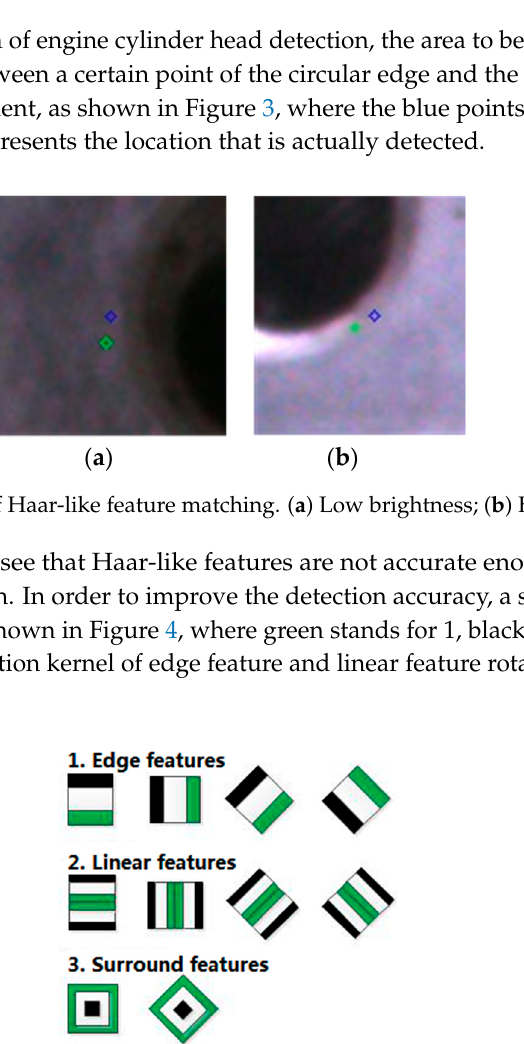
Figure 2. Improved Haar-like feature operators.